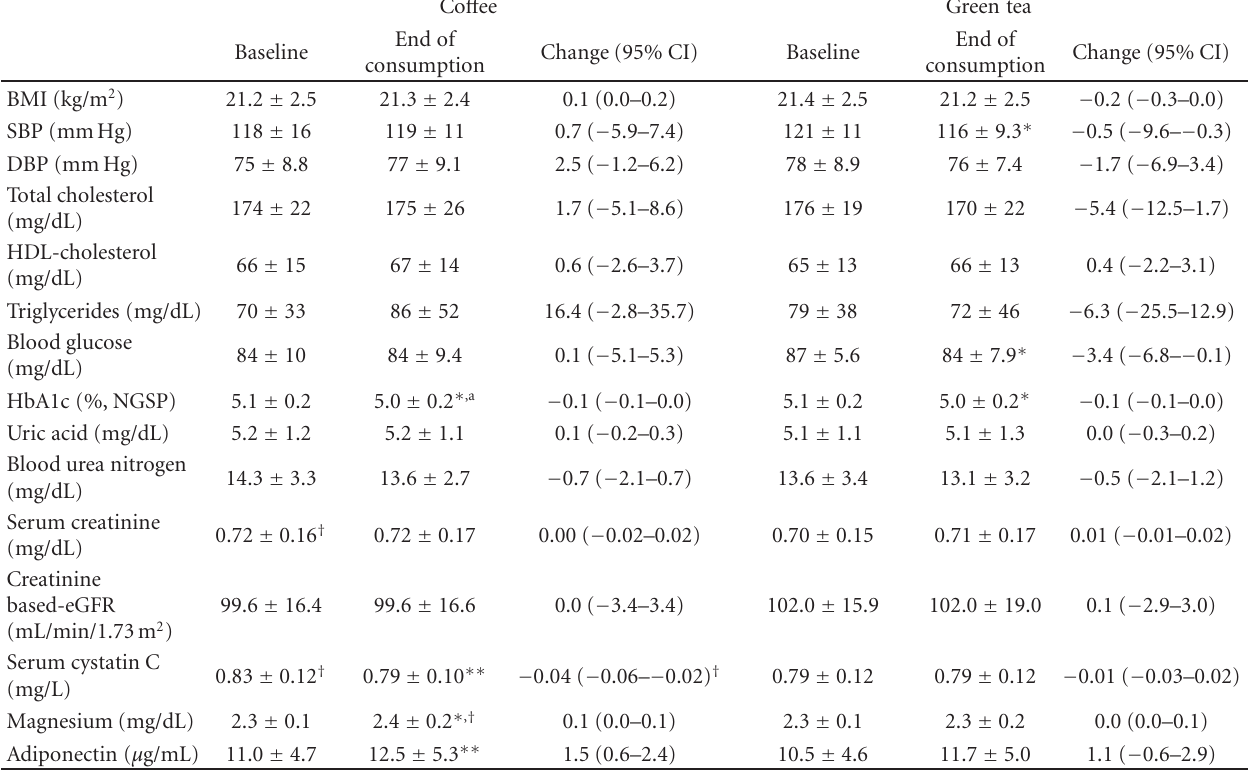
Table 2: Changes in variables according to co ff ee and green tea consumption.